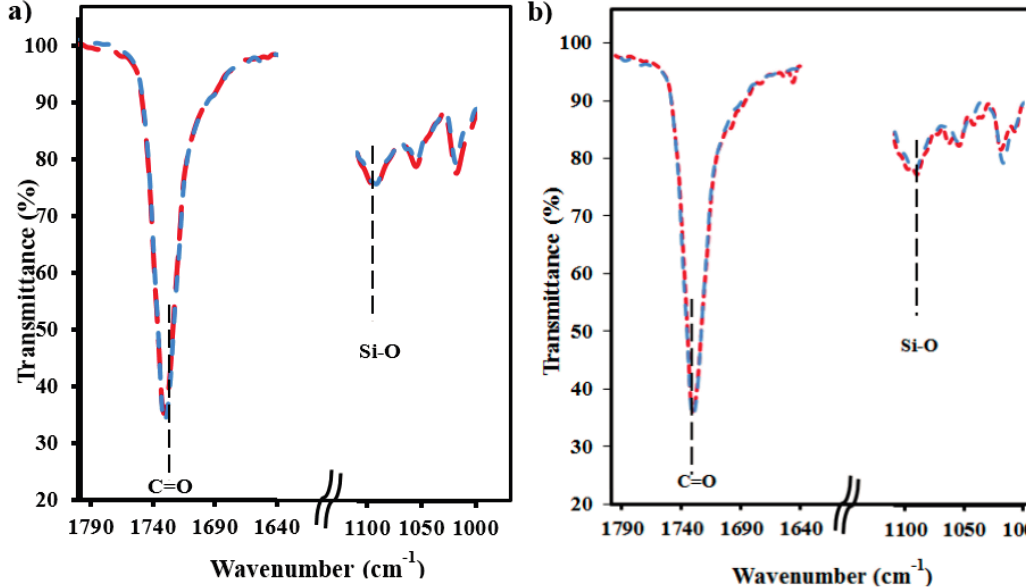
Figure 8. FTIR spectra of the characteristic C=O and Si–O stretching bands of micro-molded PE-N 3 ( a ) and PE-M 3 ( b ) specimens. Blue and red lines correspond to the proximal and distal parts of the specimens,